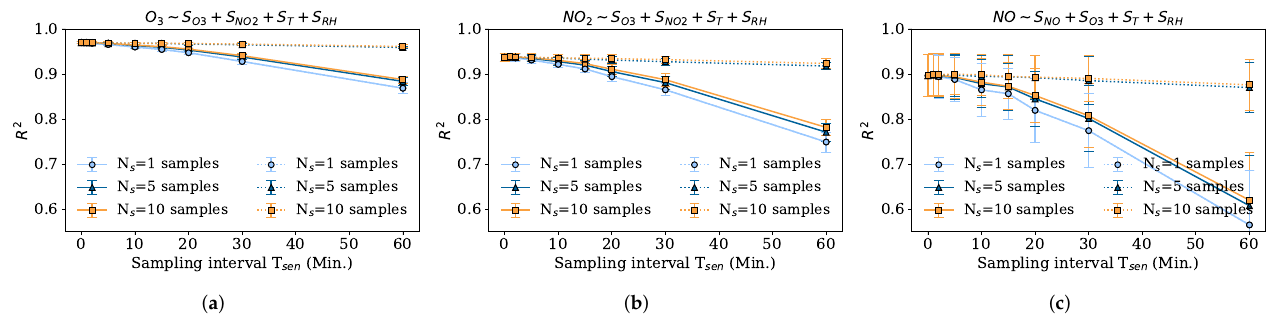
Figure 5. Average CV R 2 and 95% confidence intervals for different sampling settings using MLR; sampling period T sen and number of consecutive samples N s taken every period T sen . The solid lines denote the strategy that the N s samples are taken consecutively after a sensor response period, and the dotted lines denote the strategy that the N s samples are taken uniformly at T sen . ( a ) Captor 20001 O 3 CV R 2 for different T sen and N s . ( b ) Captor 20001 NO 2 CV R 2 for different T sen and N s ; ( c )